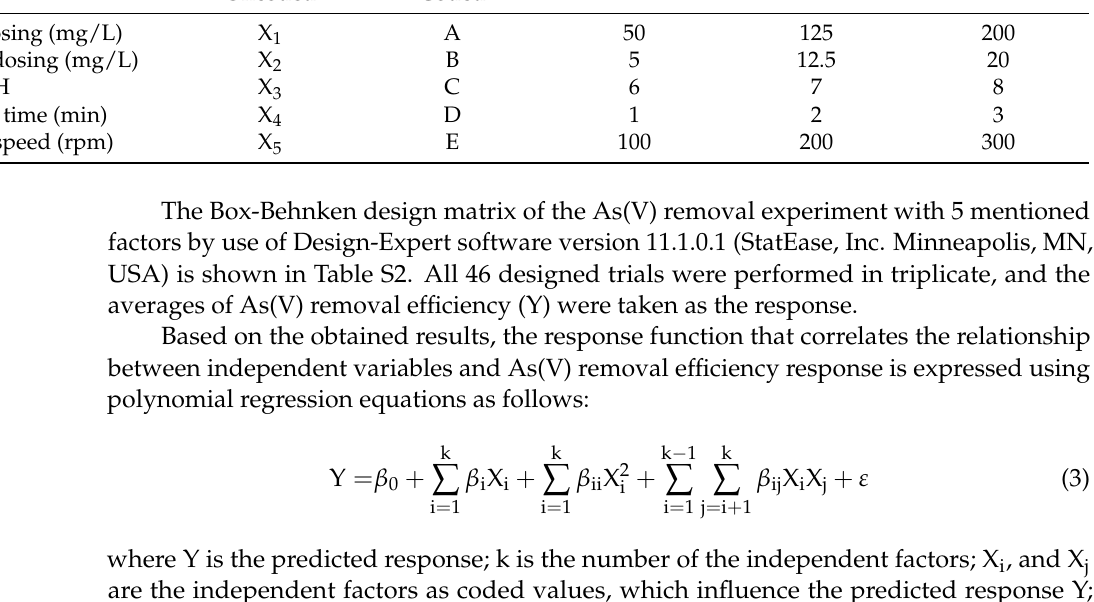
Table 4. Levels of effective variables in Box-Behnken design of As(V) removal via coagulation-flocculation.